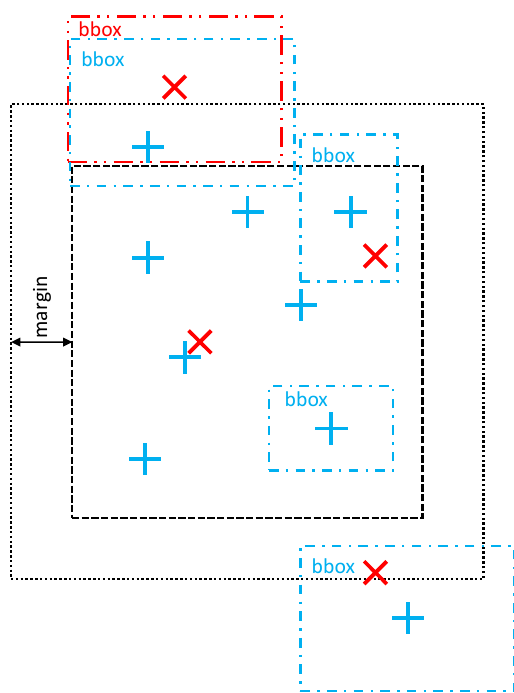
Figure 4. Example of a selection of candidate entities for partition-based